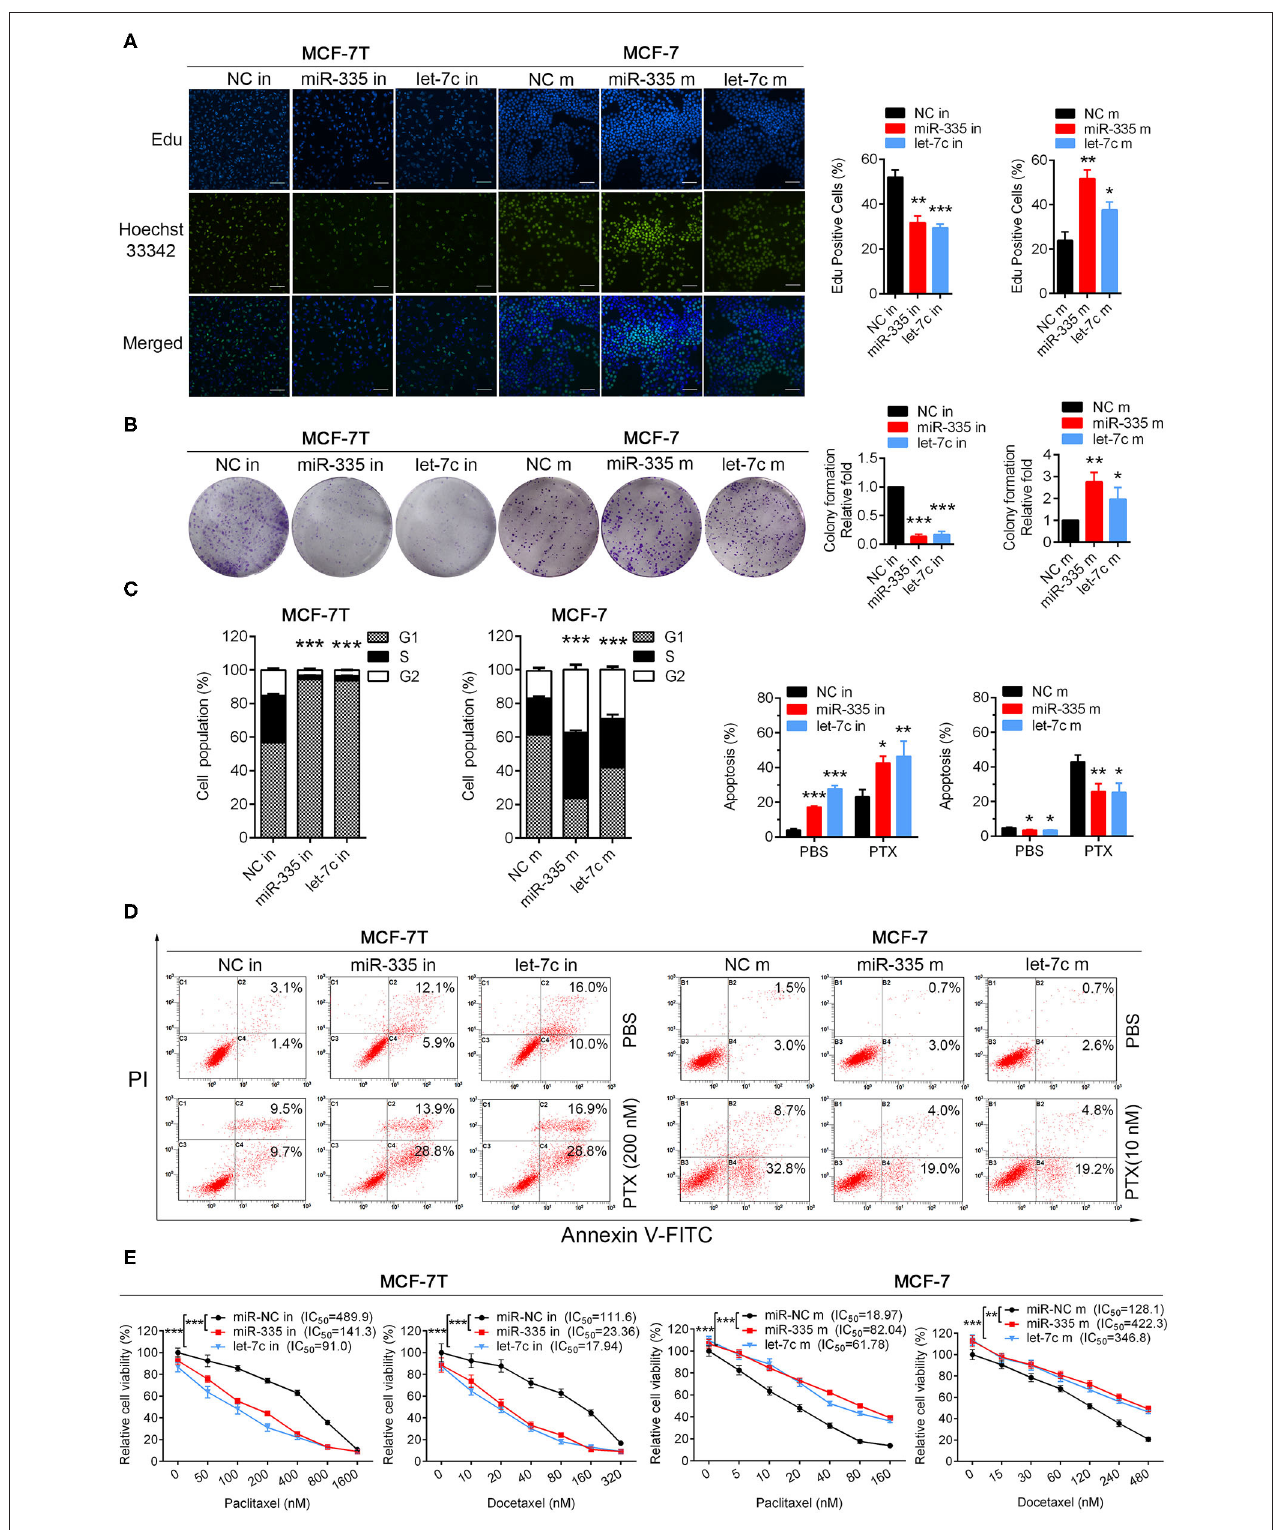
FIGURE 2 | Validation biological functions of selected miRNAs in paclitaxel-resistant/sensitive cells. (A) Edu incorporation assays, (B) colony formation assays, (C) cell cycle assays were performed both in MCF-7/T and MCF-7 cells. (D) Apoptosis rate was detected in miR-335-5p/let-7c-5p-overexpressing cells and miR-335-5p/let-7c-5p-decreasing cells with or without paclitaxel. (E) The IC 50 to paclitaxel and docetaxel was detected by MTT assays. All experiments were performed at least three times independently. The data were presented as the mean ± SD . * P < 0.05, ** P < 0.01, *** P < 0.001. Scale bar: 500 µ M.